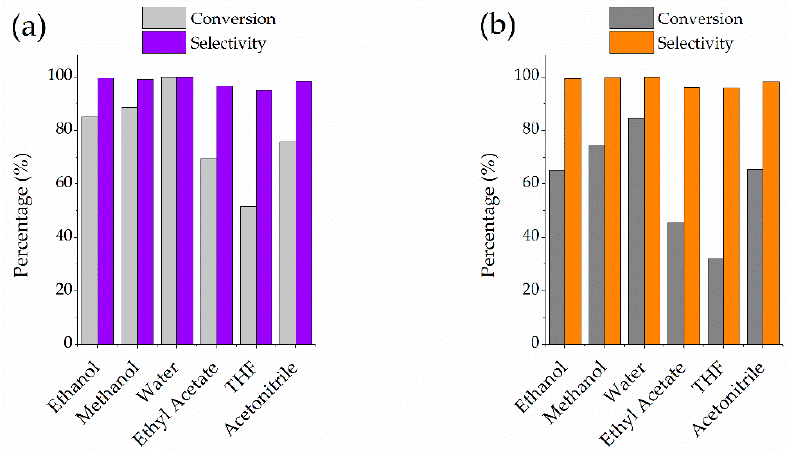
Figure 7. Effect of the solvent on the activity and selectivity in the hydrogenation of the selected nitroarenes at 30 min of reaction. ( a ) 4-(2-fluoro-4-nitrophenyl)-morpholine (NFMF) and ( b ) 4-(4-nitrophenyl)-3-morpholinone (NFMO).